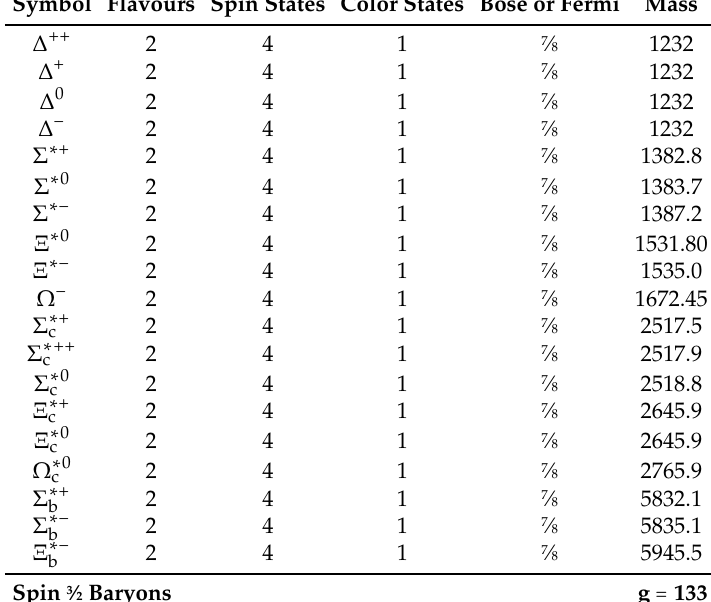
Table D2. Spin 3 ⁄ 2 baryons.